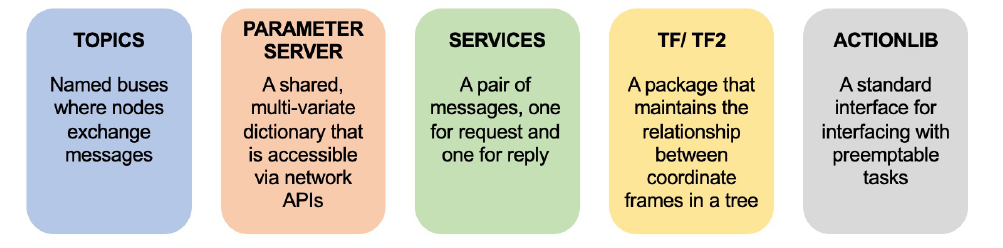
Figure 2. ROS resources that are commonly used for the development of medical robotic systems. Definitions taken from ROS wiki pages